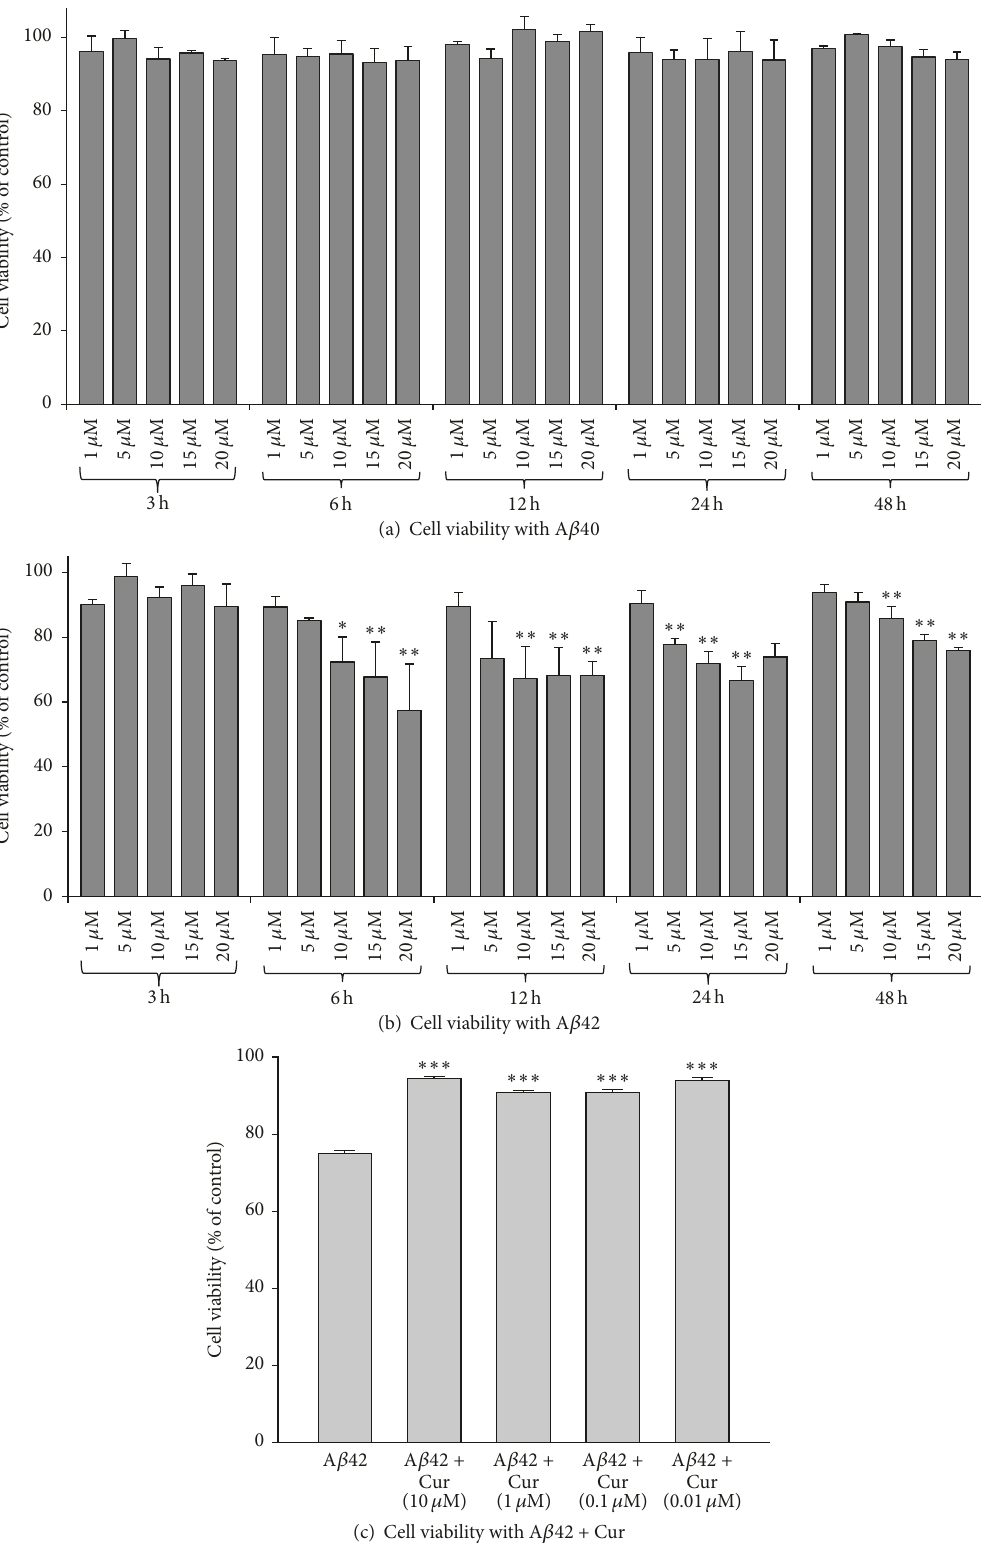
Figure 2: Cell viability after exposure to different concentrations of A 𝛽 0 and A 𝛽 42 at different time points and the protective effects of Cur. N2a cells were treated with different concentrations of A 𝛽 40 and A 𝛽 42 ( 𝜇 M) at different time points, respectively. Data are expressed as mean ± SD. (a) No significant neurotoxicity was observed in the case of A 𝛽 40 treated cells. (b) Cell viability tended to decrease with decreasing concentrations and increasing time with A 𝛽 42 incubation. ∗ 𝑝 < 0.05 ; ∗∗ 𝑝 < 0.01 compared to control. (c) All concentrations of Cur prevented neuronal death following exposure to 10 𝜇 M of A 𝛽 42 for 24 h ( ∗∗∗ 𝑝 < 0.001 relative to A 𝛽 42